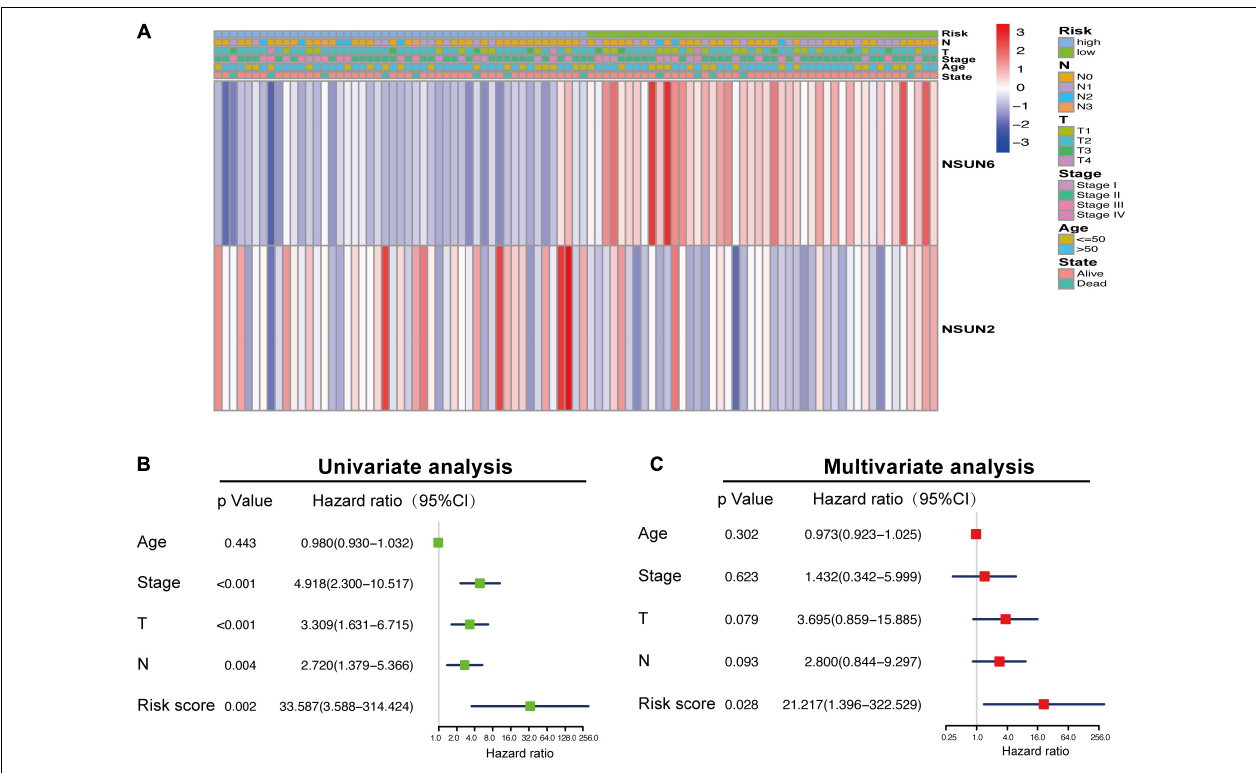
FIGURE 3 | Association between the clinicopathological characteristics and prognostic risk score. The heat map showing the difference in NSUN2 and NSUN6 expression and clinicopathological differences between the high-risk and low-risk groups (A) . Univariate and multivariate Cox regression analyses of the association among clinicopathological characteristics, risk score, and overall survival (B,C) . NSUN, NOP2/Sun domain family member.